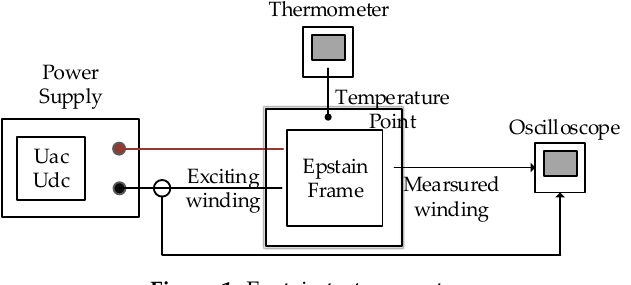
Figure 1. Epstein test apparatus.